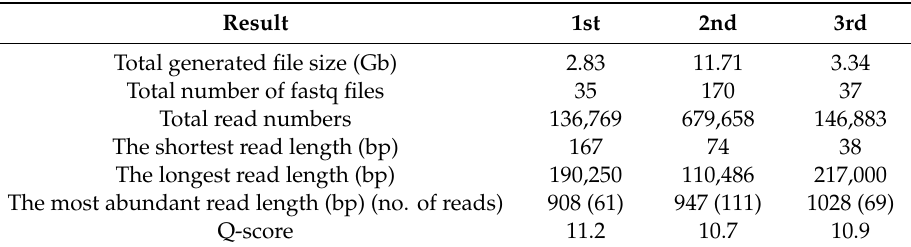
Table 1. The statistics of the raw fastq file.